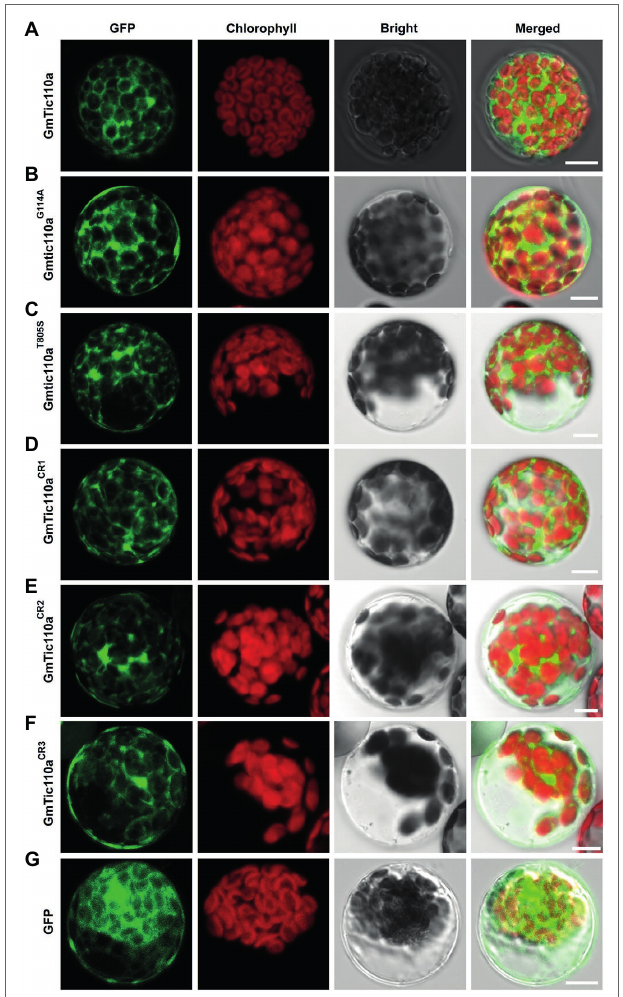
FIGURE 5 | Subcellular localization of GmTic110a, GmTic110a G114A , Gmtic110a T805S , GmTic110a CR1 , GmTic110a CR2 , and GmTic110a CR3 . (A-G) Transient expression of GFP-GmTic110a, GFP-GmTic110a G114A , GFP- Gmtic110a T805S , GFP-GmTic110a CR1 , GFP-GmTic110a CR2 , GFP-GmTic110a CR3 and GFP in Arabidopsis protoplasts. GFP, GFP fluorescence; Chlorophyll, chlorophyll autofluorescence; Bright, bright field. Merged, merged image of GFP fluorescence, chlorophyll autofluorescence and bright field images. Scale bars = 10 μ